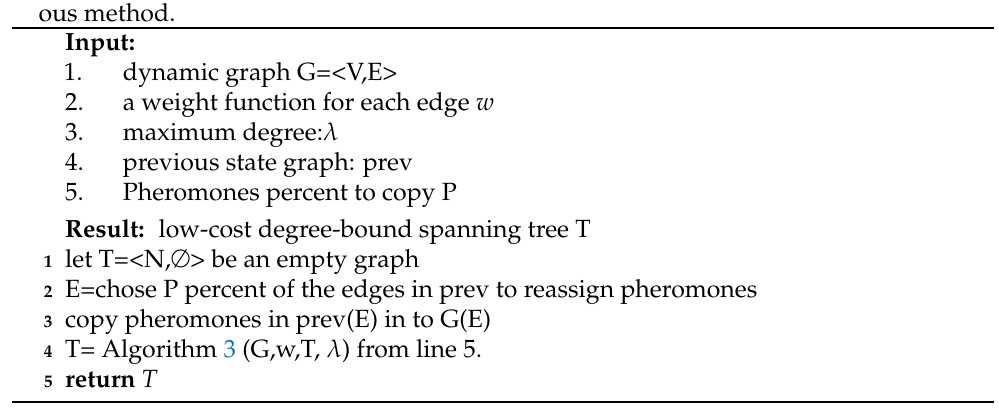
Algorithm 5: AC algorithm for low-cost degree-bound spanning tree: continu- ous